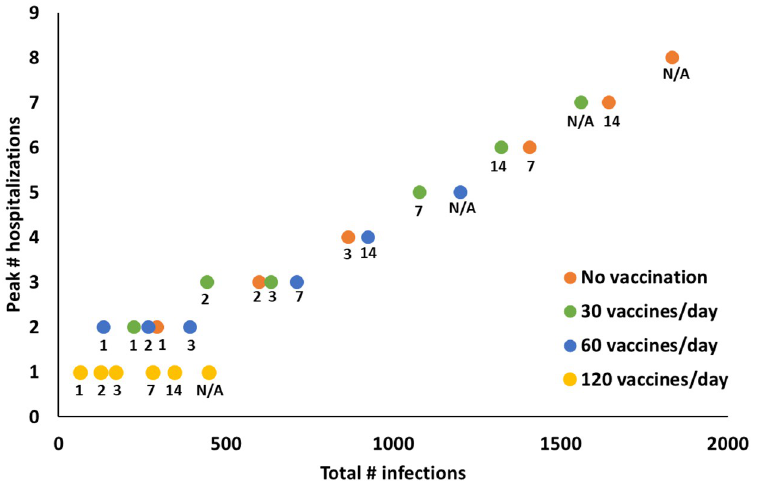
Fig 2. Peak number of hospitalizations versus total number of infections for 60% initial campus-wide vaccine coverage ( L = L = 60%) and 75% compliance ( η = α = 75%) in the base-case scenario with full screening. N/A s f represents “no screening”.